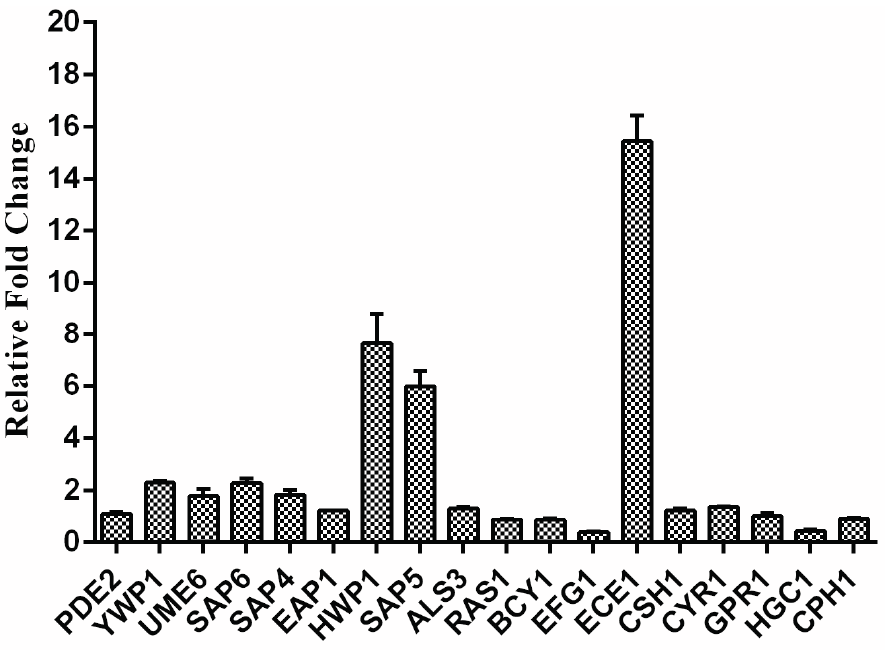
Figure 6. The expression changes of some important biofilm formation related genes after 8 μ g/mL RM treatment. The C. albicans strain tested was SC5314. Gene expression was indicated as a fold change relative to that of the control group. 18S rRNA was used to normalize the expression data. Data are means ± standard deviations from three